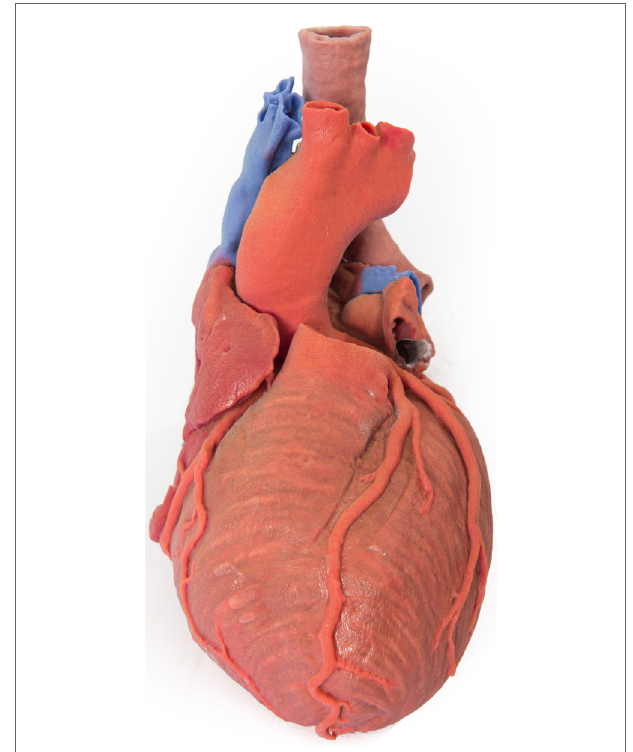
FiGURe 2 | 3D-printed haptic model of a heart and the great vessels fabricated using Projet x60 series 3D printers . Reproduced with permission from Centre for Human Anatomy and